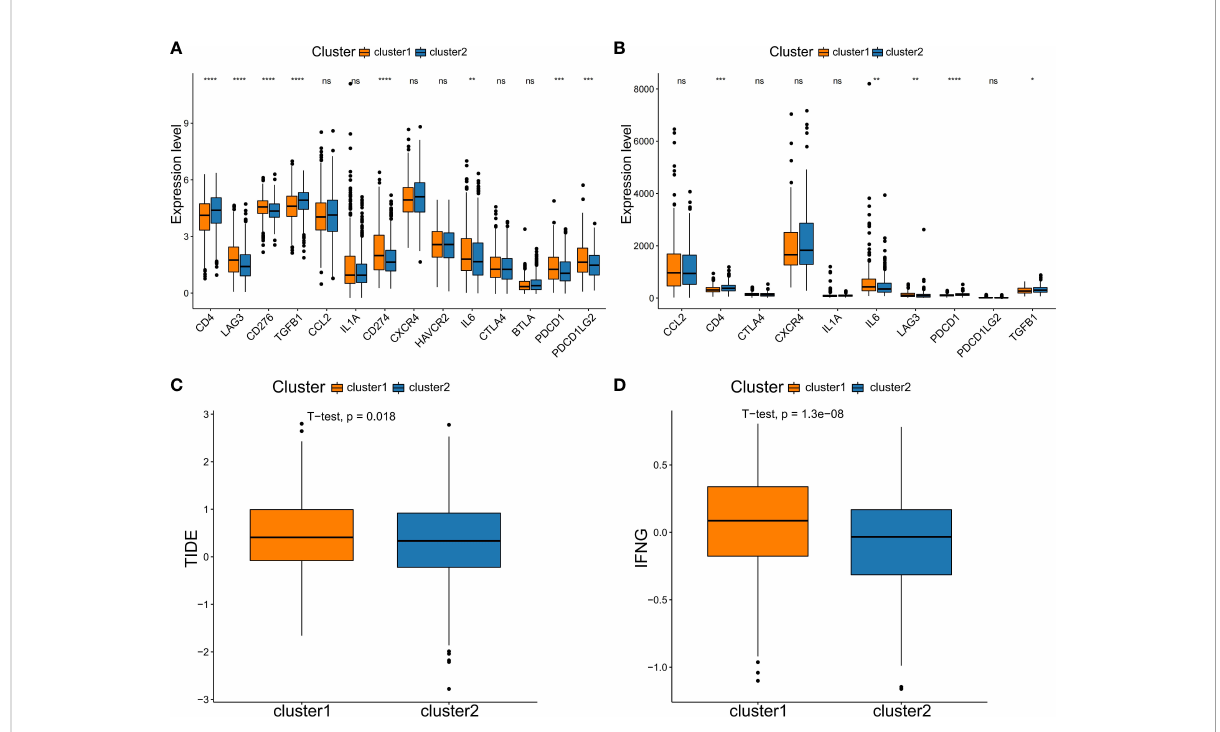
FIGURE 6 Comparison of immune checkpoint molecules expression and TIDE scores between subtypes. Comparison of the expression of immune checkpoint genes in two subtypes in the training set (A) and testing set (B) . (C) TIDE analysis. (D) The expression score of the response prediction biomarker, IFNG, was computed using TIDE analysis. NS denotes P>0.05, * indicates P ≤ 0.05, ** represents P ≤ 0.01, *** indicates P ≤ 0.001, and **** indicates P ≤